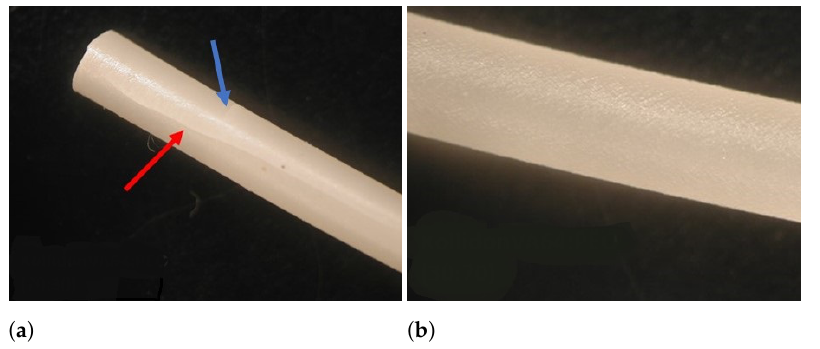
Figure 5. ( a ) Visualization of longitudinal and transversal fissures on the surface of a Kollidon VA64:PEO (70:30) blend processed at 140°C and ( b ) absence of these extrusion defects for a Kollidon VA64:PEO blend (30:70) at 140°C.